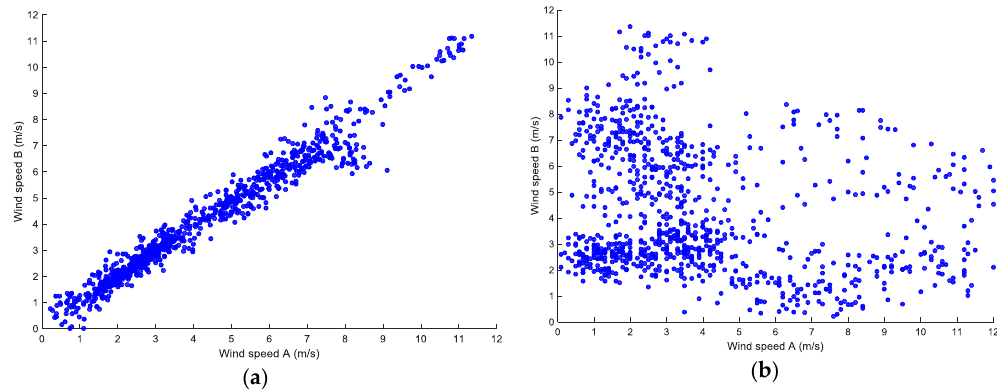
Figure 3. Scatter diagrams of paired wind speed values: ( a ) linear correlation of wind speed A and B; ( b ) nonlinear correlation or no-correlation of wind speed A and B.